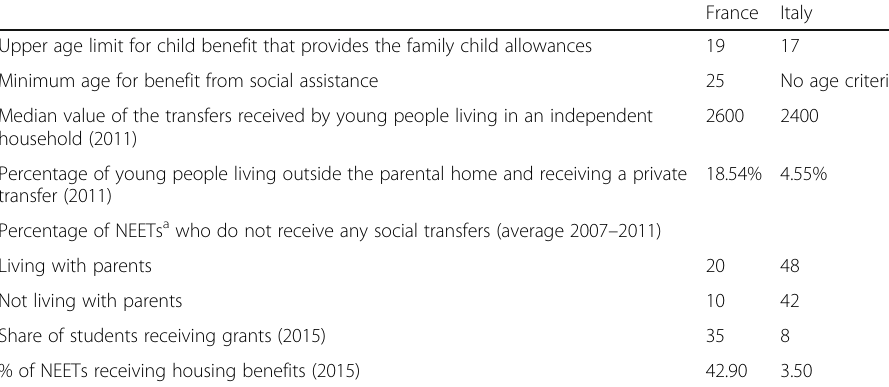
Table 9 Indicators concerning welfare support for young people in France and Italy